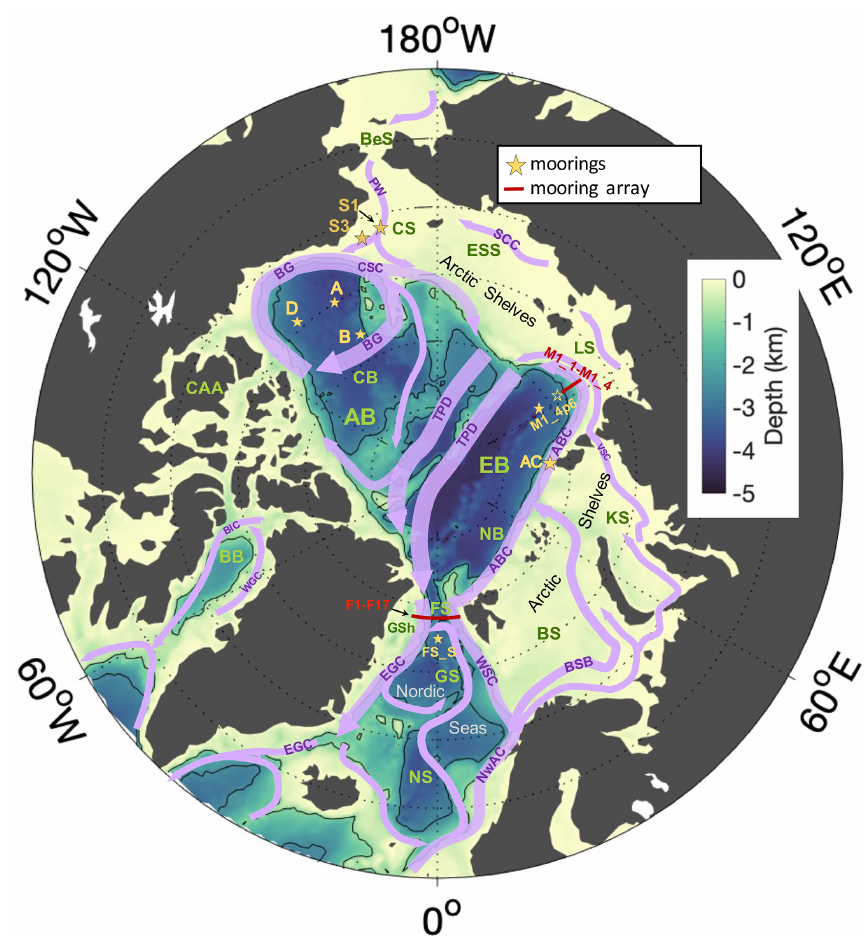
Figure 1. Arctic Ocean map and bathymetry (IBCAO, Jakobsson et al., 2012) with the main sub-regions (green acronyms) and the mean surface circulation pathways (purple arrows and abbreviations). Locations of moorings used for validation are indicated with yellow stars and red dotted lines: at the Laptev Sea continental slope, the empty star indicates where the bottom pressure data are taken. Depth contours are drawn at 1000 and 2500m depths. Regions: Nordic Seas: Greenland Sea (GS), Norwegian Sea (NS); Arctic shelves: Barents Sea (BS), Kara Sea (KS), Laptev Sea (LS), East Siberian Sea (ESS), Chukchi Sea (CS), Greenland Shelf (GSh); Arctic deep basins: Amerasian Basin (AB), Canada Basin (CB), Eurasian Basin (EB), Nansen Basin (NB); Baffin Bay (BB); Canadian Arctic Archipelago (CAA); Fram Strait (FS); Bering Strait (BeS). Currents: West Spitsbergen Current (WSC); Norwegian Atlantic Current (NwAC); Barents Sea Branch (BSB); Vilkitsky Strait Current (VSC); Arctic Boundary Current (ABC); Siberian Coastal Current (SCC); Pacific Water inflow (PW); Chukchi